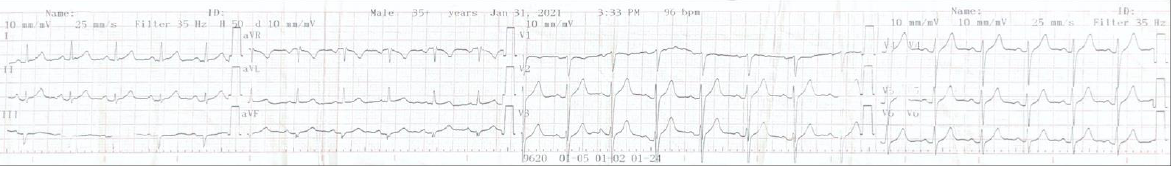
Figure 2. Chest radiography of the patient showing normal radiological findings. 3. Discussion Within 12 months since the RNA sequence of SARS-COV2 was published, two RNA vaccines against COVID-19 have been licensed and are broadly used in many parts of the world [9,10]. One of them was developed from the company Pfizer-BioNTech and was licensed for use in many countries worldwide. Nowadays, millions of people have been administered this specific vaccine, with side effects reported and now included in the drugs Summaries of Product Characteristics (SPC). However, due to fast-track develop- ment of this new vaccine, many side effects would not have been included in the SPC, and the reporting of side effects by physicians is imperative. All the available data on COVID- 19 vaccine side effects have been published by manufacturer-funded studies, which are of course in compliance with the Food and Drug A uthorities’ guidelines and monitored by third parties [11]. This lack of independent studies on vaccines safety may adversely im- pact the vaccine uptake and thus slow down vaccine roll-out programs, which are imper- ative to be accelerated in the next few months [12]. All available evidence so far supports the conclusion that mRNA vaccines are bene- ficial but may cause some adverse effects including pain, redness, or swelling at the site of the vaccine shot, nausea, vomiting, fever, fatigue, headache, muscle pain, itching, chills,